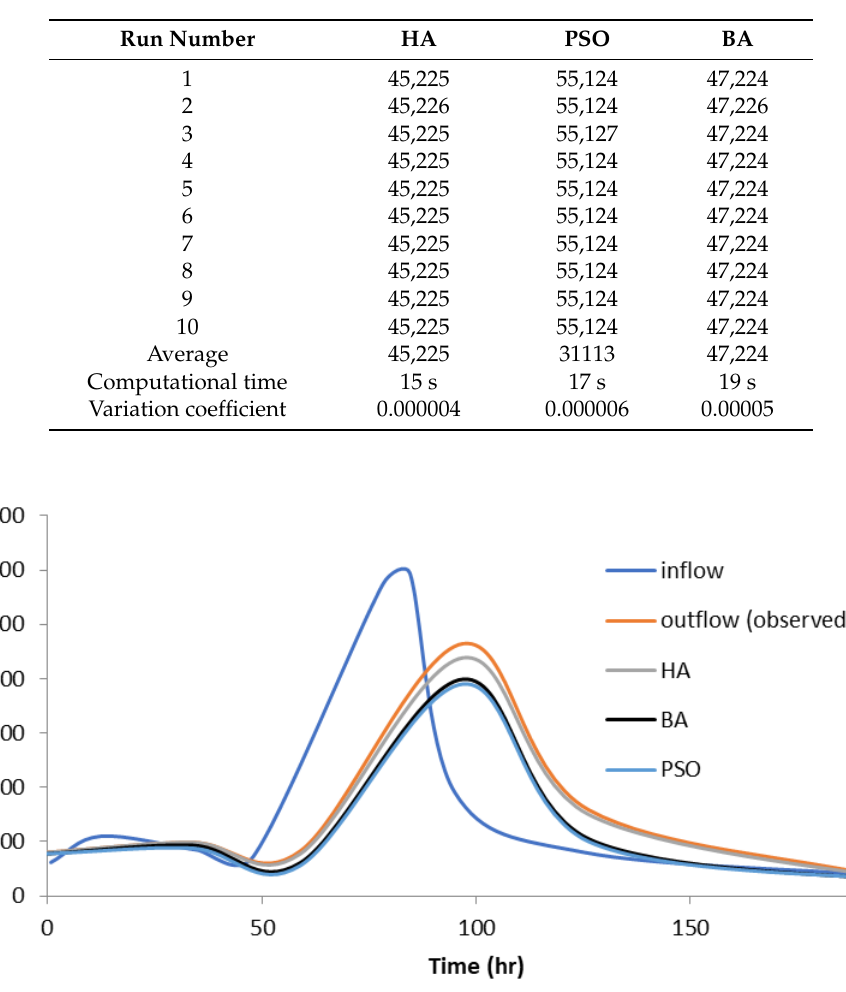
Table 17. Investigation of different methods for Karahan flood.